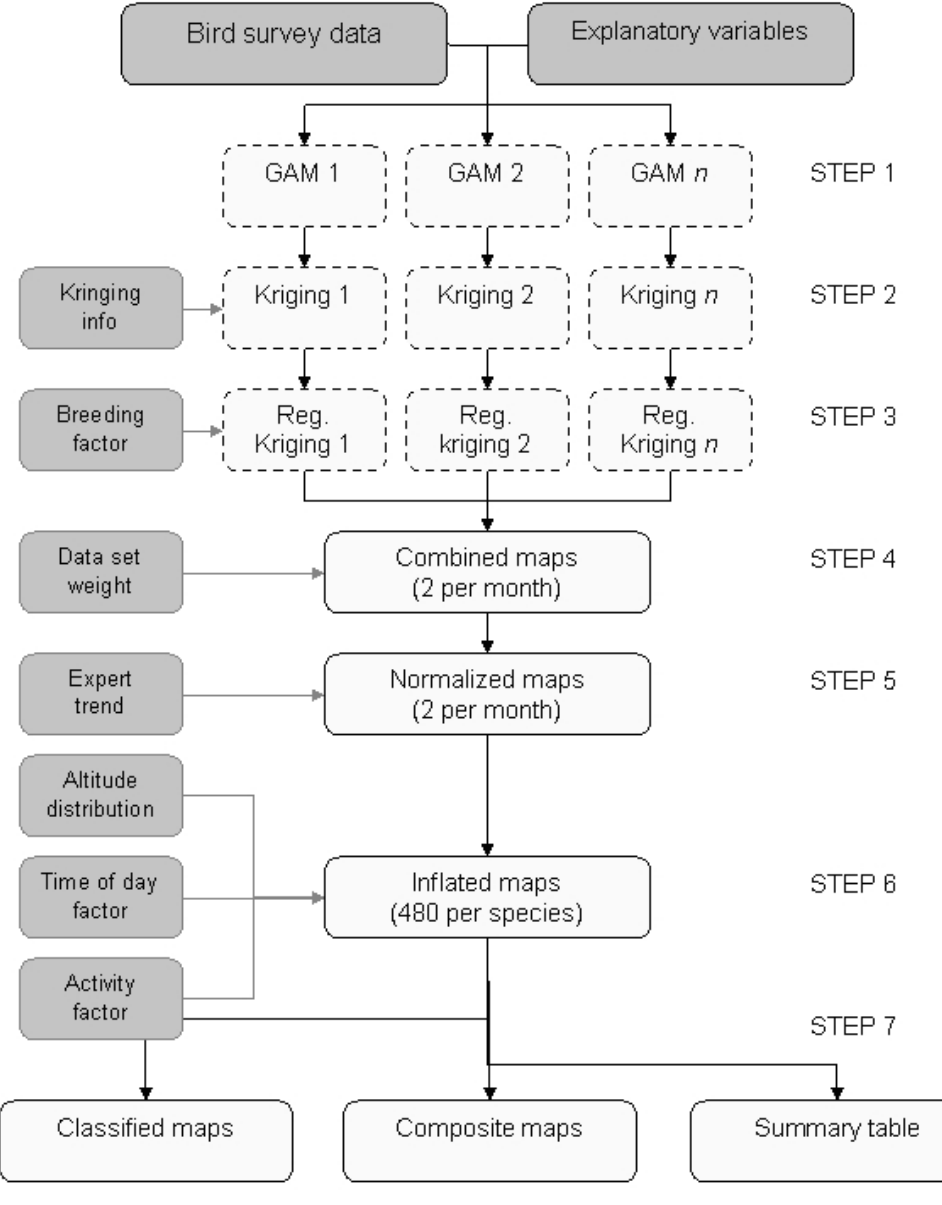
Fig. 1. A diagram of the Netherlands bird avoidance model (NL-BAM) workflow describing the modeling and processing procedures used to produce the NL-BAM maps. Central boxes represent the processing steps described in the text and in Table 1. Boxes with dashed lines represent processing steps that were repeated for each type of survey data. For example, for the buzzard, a separate general additive model was fit to the breeding bird survey as well as each of the four nonbreeding point surveys. Boxes shaded in grey represent supporting information needed to perform specific